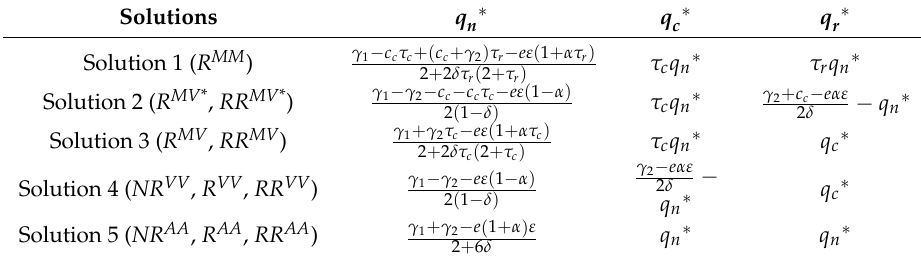
Table 6. Optimal decisions of the manufacturer considering carbon cap-and-trade regulation. Solutions